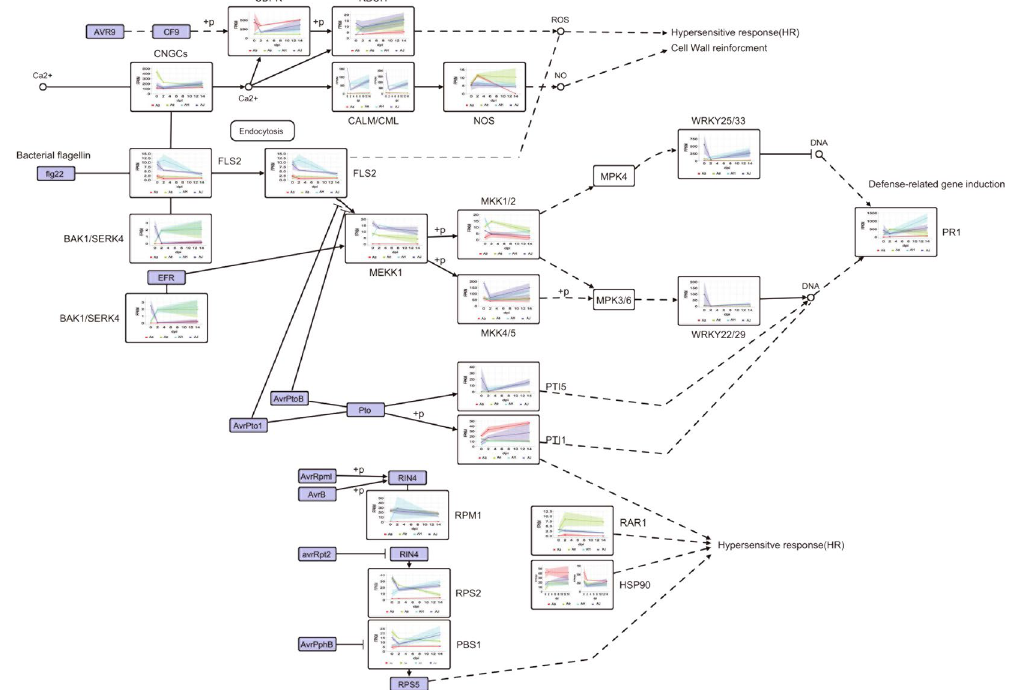
Figure 4. Visualization of plant–pathogen interaction pathways. Changes in gene expression are shown in line graphs. Each line represents the changes of a sample across three consecutive sampling time-points. The red, green, cyan and blue lines represent AH, AJ, Aa and Ae